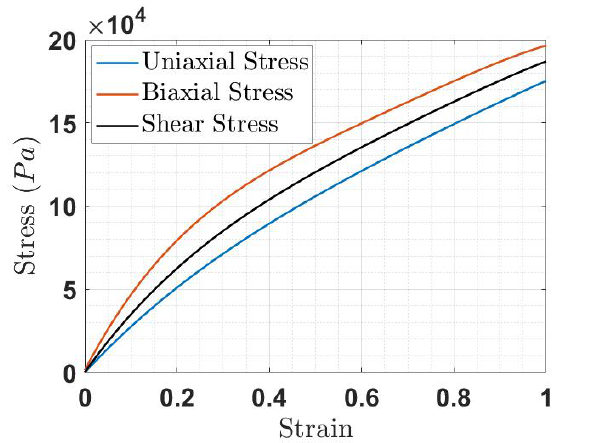
Figure 24. Material properties of the applied hyperelastic